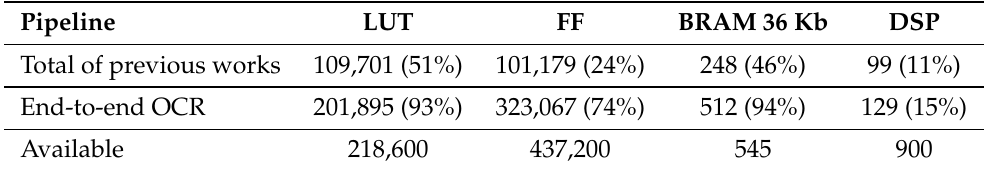
Table 4. Resource utilization of the hardware implementation for the end-to-end OCR i DocChip